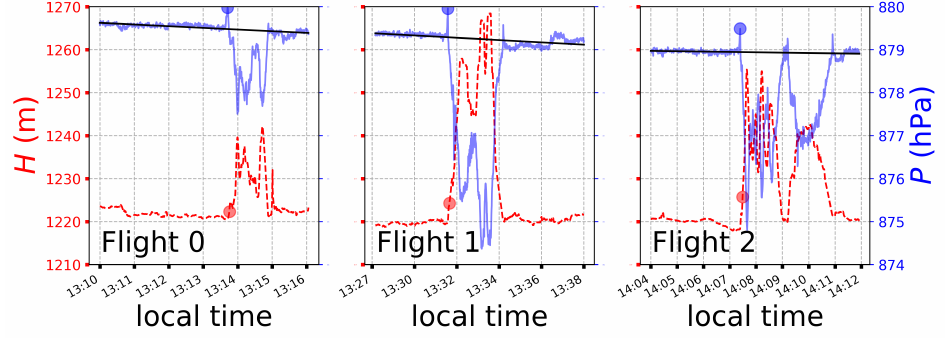
Figure 6. Altitude H in meters (red, dashed line) and pressure P in hPa (blue, solid line) vs. local time. The solid black line shows a linear trend, with the flights (upward excursions in altitude and downward excursions in pressure) masked out. The red and blue dots represent the estimated launch